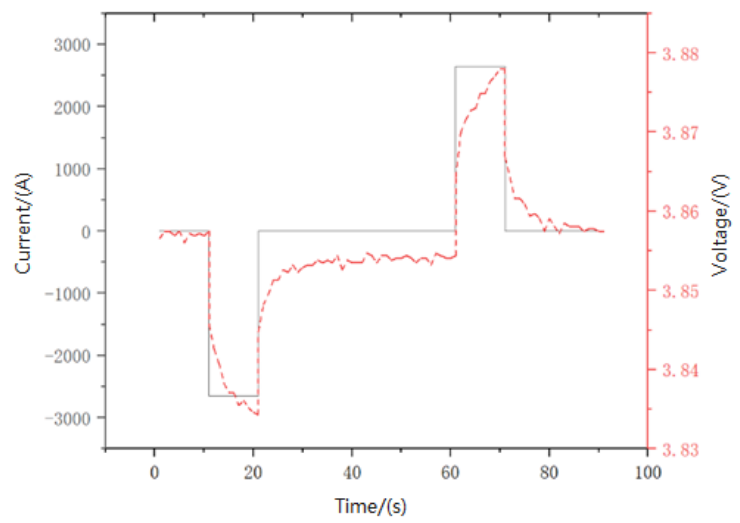
Figure 5. HPPC test data diagram.